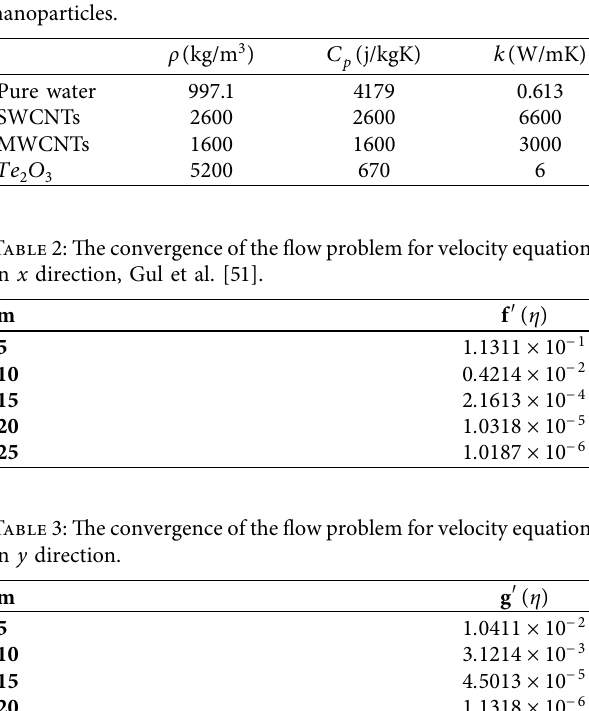
, M (heat source parameter, t